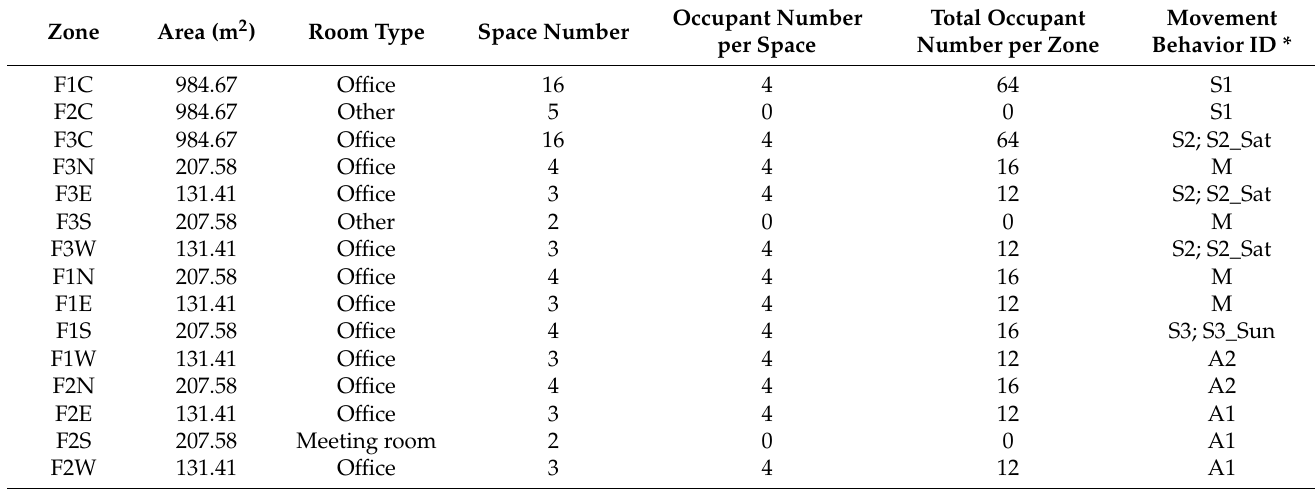
Table 2. The redefinition of the room type and movement